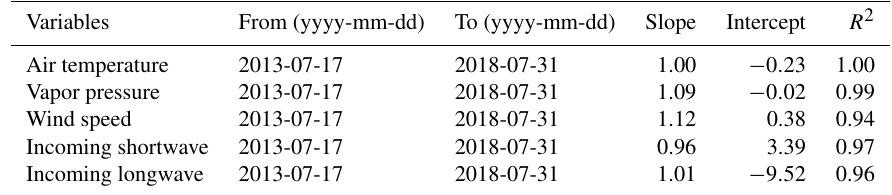
Table 4. Regression results for Peyto Main and Peyto Main Old hourly data.